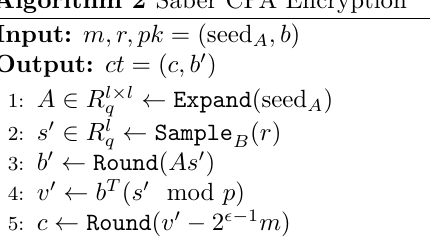
Algorithm 1 Saber Key Generation